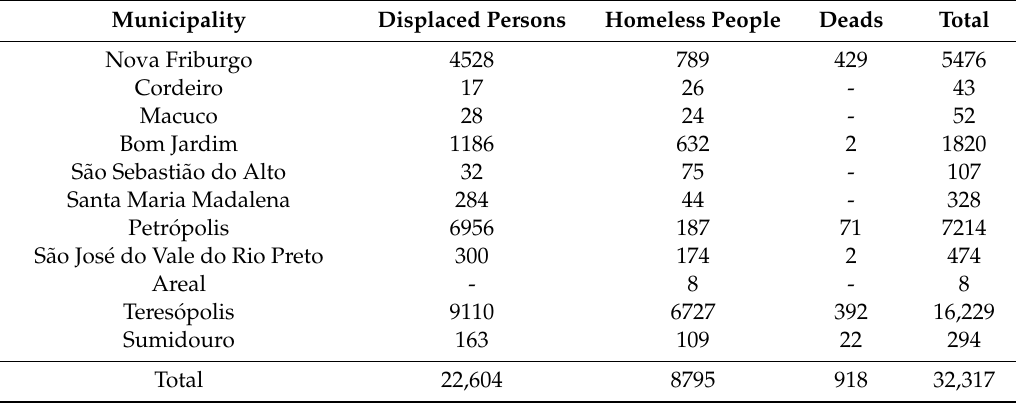
Source: Data obtained by the Civil Defense of the State of Rio de Janeiro.